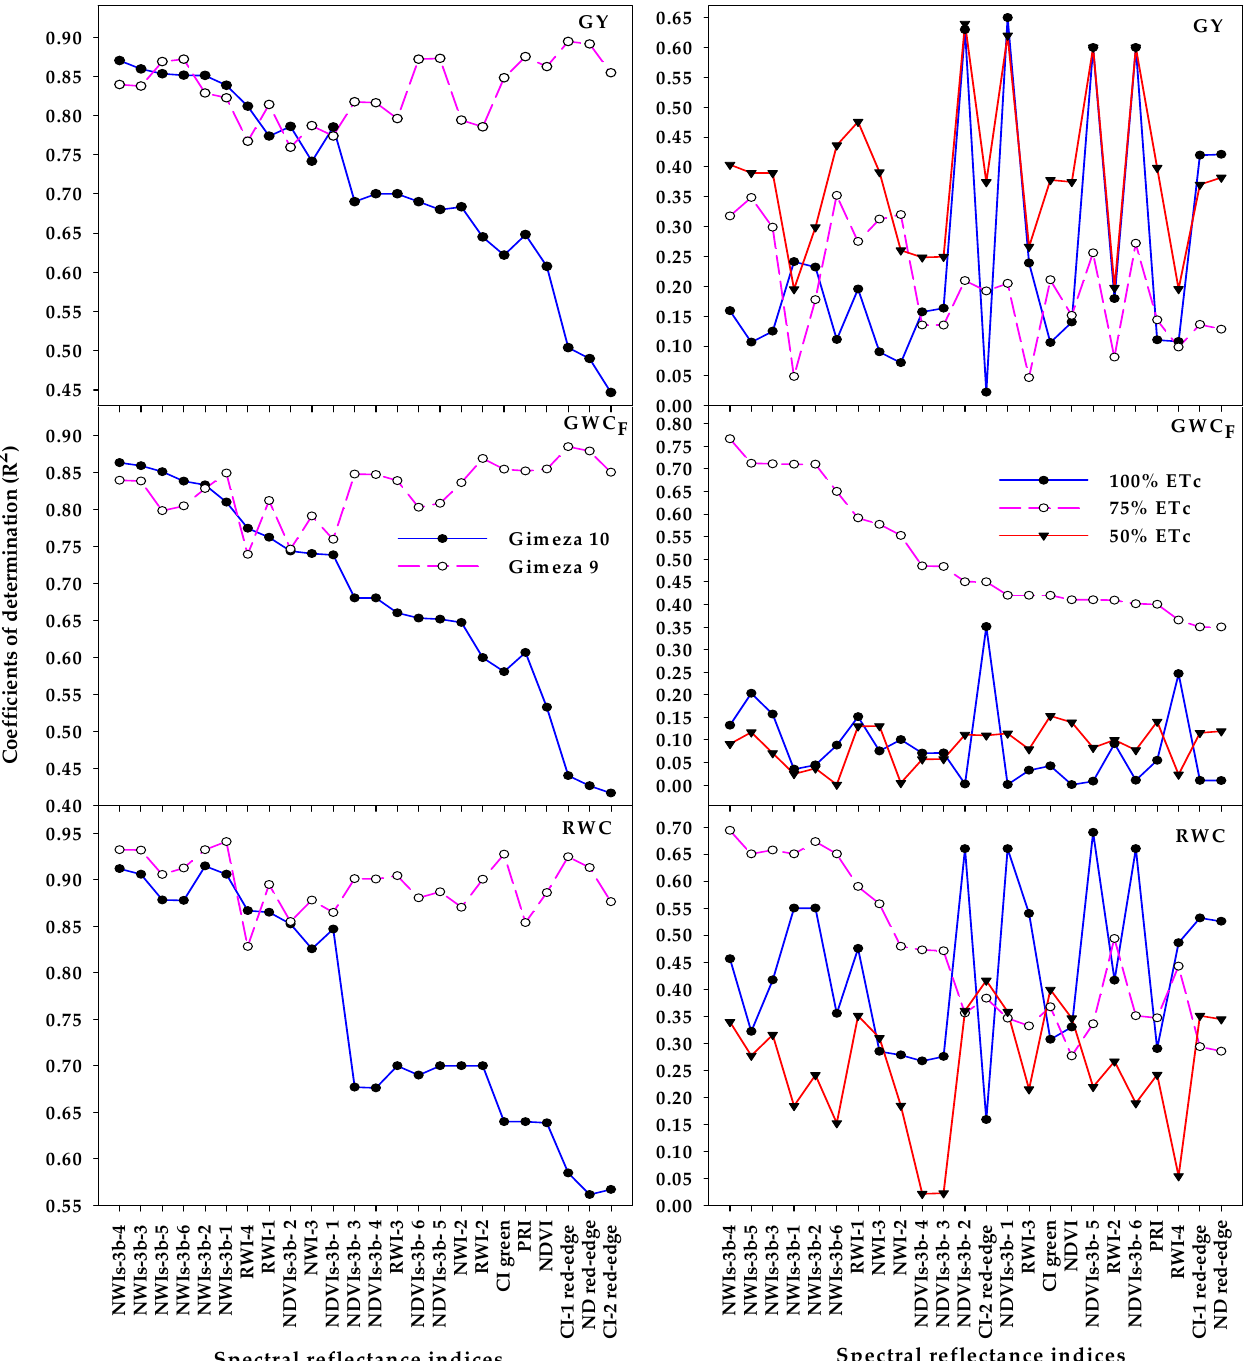
Figure 5. Coefficients of determination (R 2 ) for the relationship between different spectral reflectance indices (SRIs) and the relative leaf water content (RWC), gravimetric water content on a fresh weight basis (GWCF), and the grain yield (GY), for each cultivar and each irrigation water regime. The full names of the different SRIs are listed in Table 2.